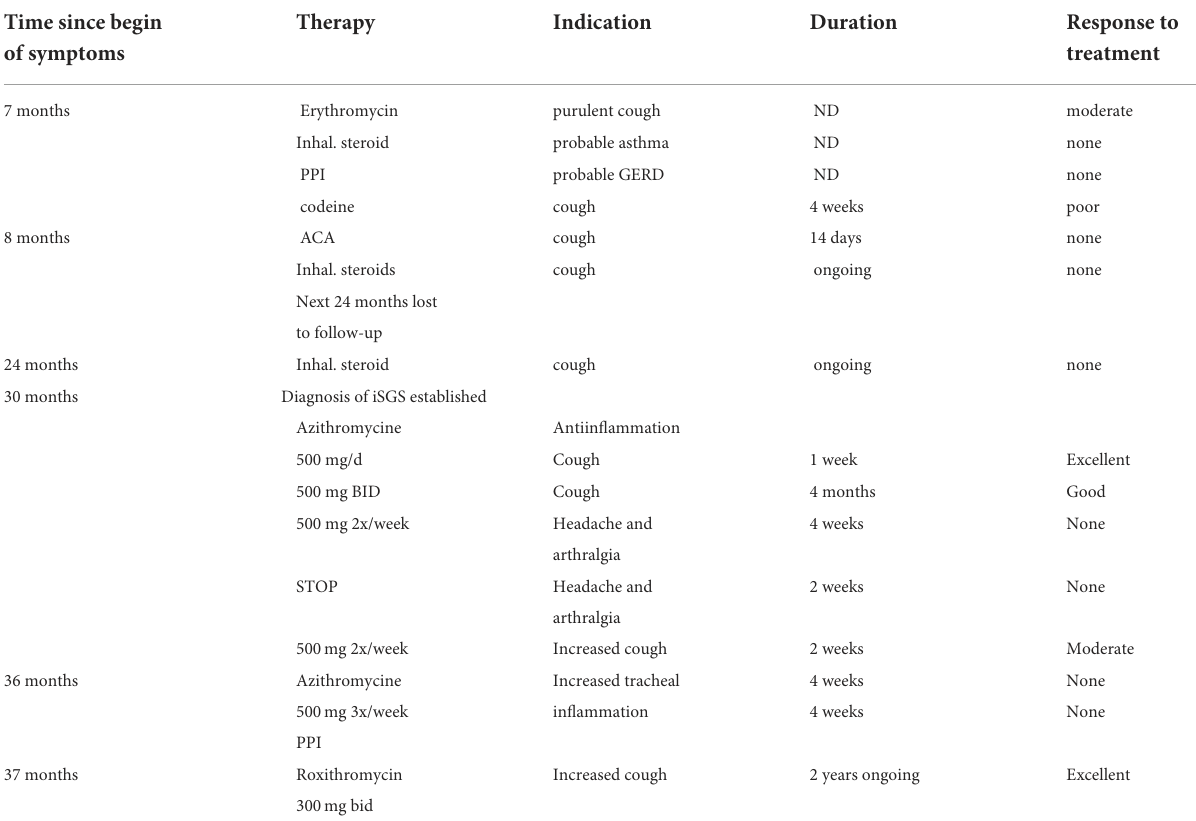
TABLE 1 Summary of applied therapies in our patient. Time since